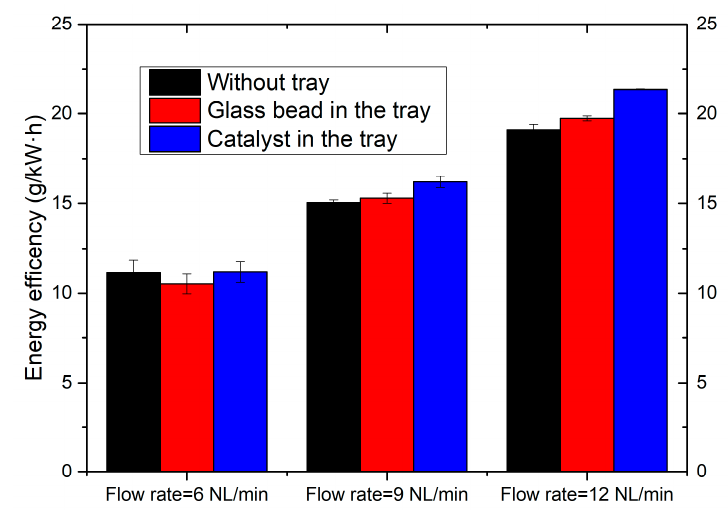
Figure 19. Effect of catalyst on energy efficiency at flow rates of 6 NL/min, 9 NL/min and 12 NL/min.